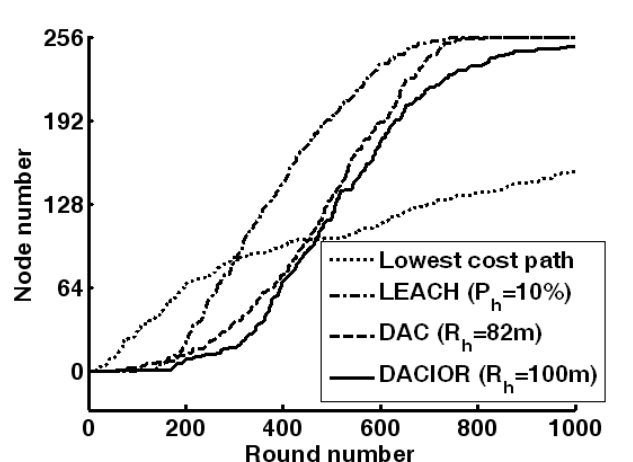
Figure 5. Number of sensor nodes which expend more energy than 3J during global DAQ with lowest cost path, LEACH, DAC and DACIOR.